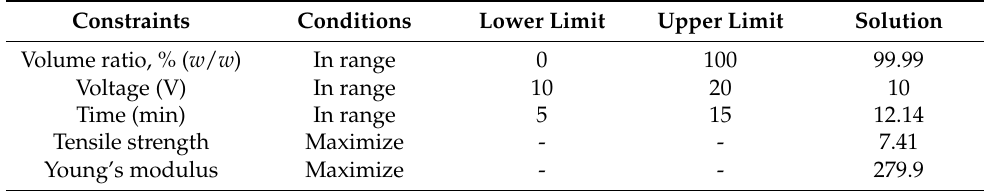
Table 13. Constraints for optimization for experimental design of 0% and 100% water. Constraints Conditions